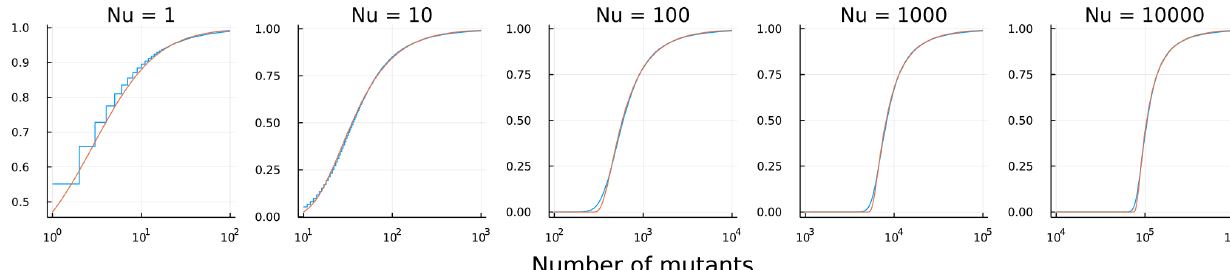
Figure 1. Cumulative distribution of the number of neutral mutants in an expanding population. Each population begins with one cell and grows to N cells. Mutation occurs at rate u . Blue curves show the distribution from a computer simulation using the simu. cultures command of the R package rSalvador 7 . Orange curves show the Fréchet distribution in Equation 1. In rSalvador, I used sample sizes of 10 6 or 10 7 , values of Nu varying as shown above the plots, and values of N ranging from 10 6 to 10 10 . The Julia software code to produce this figure is available from Zenodo 8 . The input data for calculating the empirical Luria-Delbrück CDF is also available from Zenodo 9